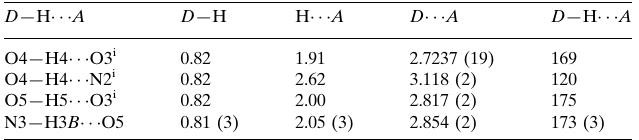
Hydrogen-bond geometry (A˚ , (cid:2)